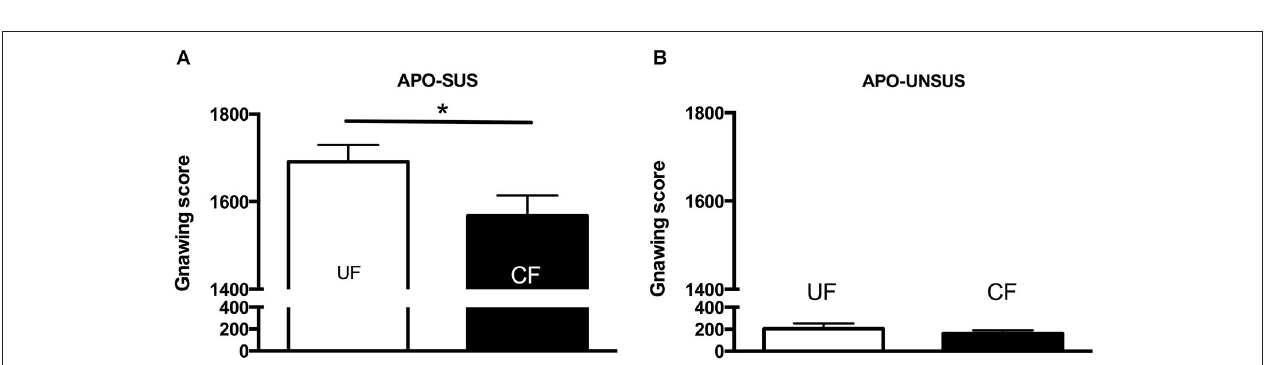
FIGURE 3 | Apomorphine-induced gnawing of APO-SUS (A) and APO-UNSUS (B) rats after being unfostered (UF; white bars) or cross-fostered (CF; black bars) in their early life. * p < 0.05. Note: No gender differences were observed.